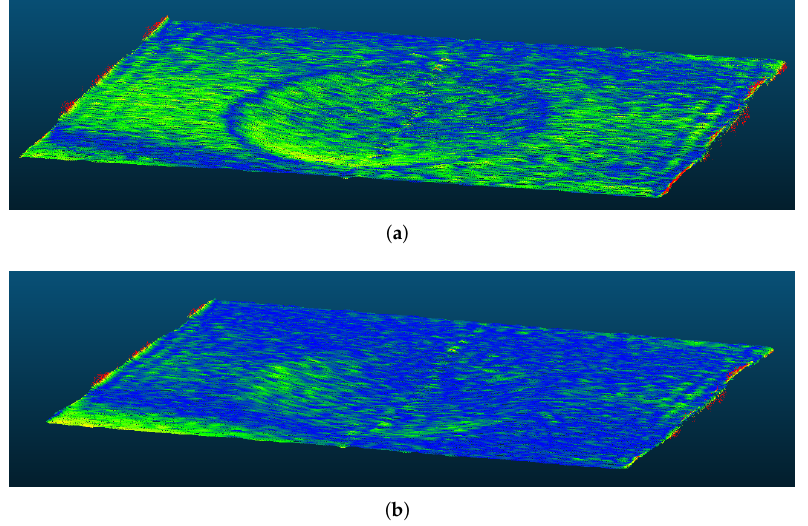
Figure 16. Comparison of 3D reconstruction for sample C (as heatmap of MAE) using Estrada’s unwrapping algorithm with the ( a ) direct mapping and the ( b ) proposed virtual reference methods. Blue areas correspond to lower error than green ones. The border artefacts of the Fourier transform are visible as high-error areas (yellow and red).